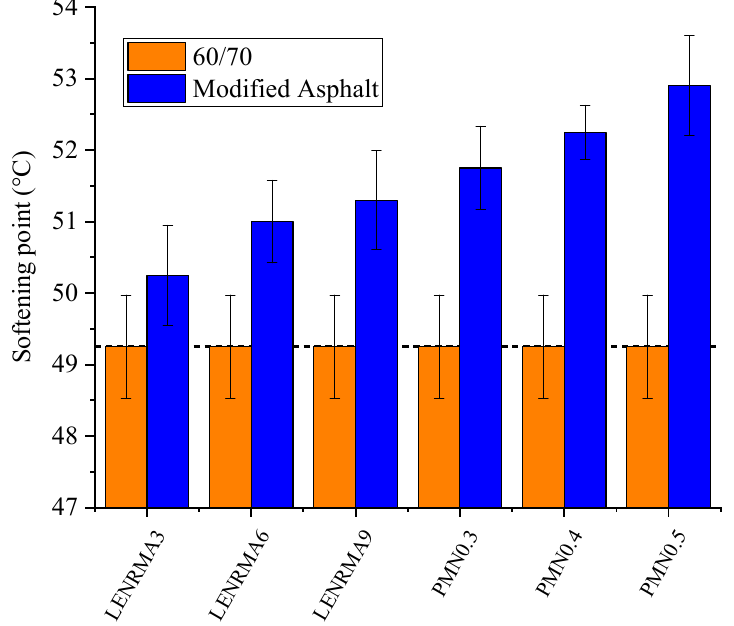
Figure 3. Softening point of all binders.